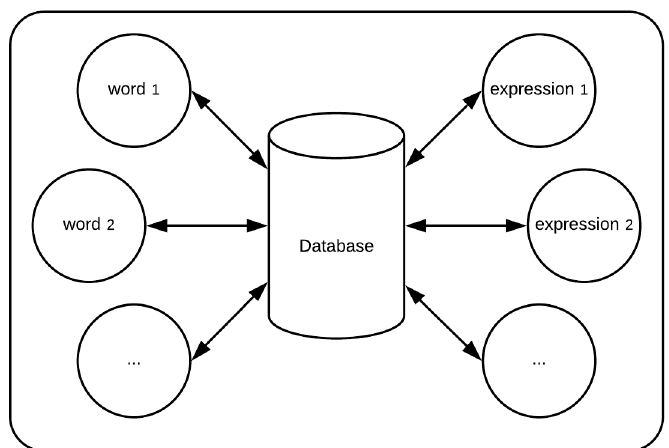
Figure 4. Data analysis searching